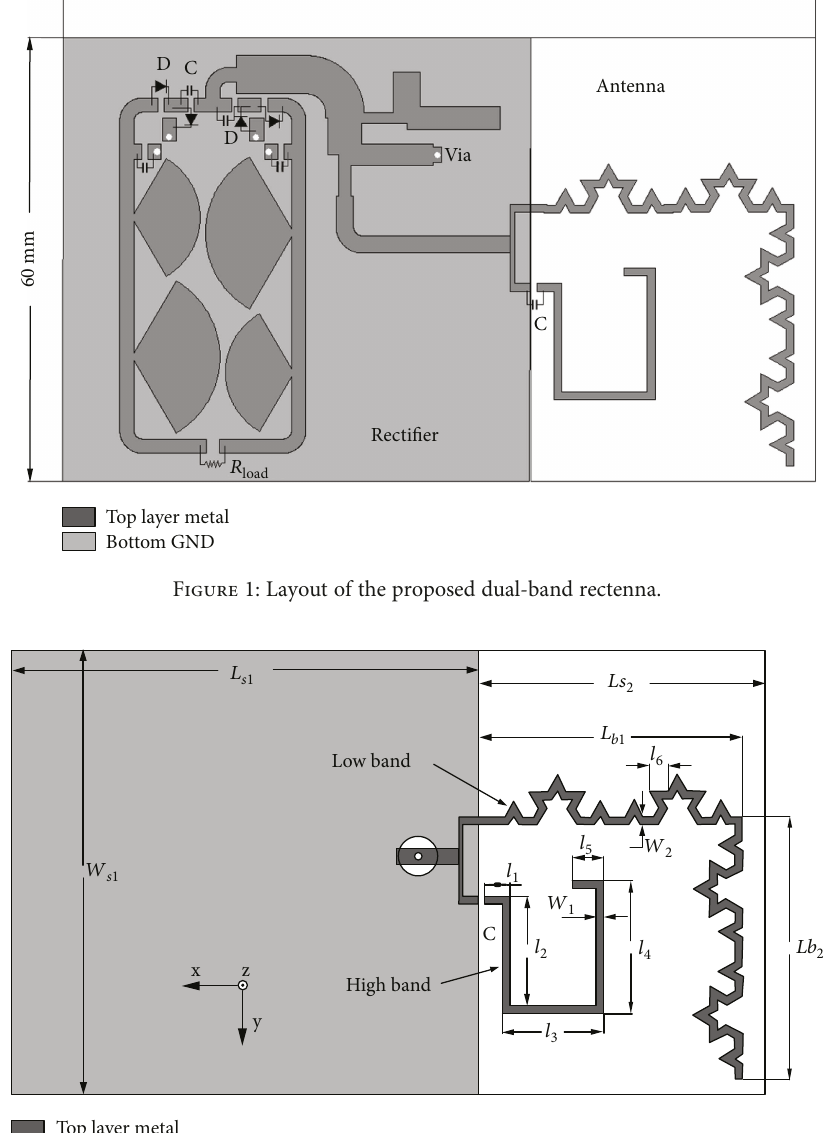
Figure 2: Layout of the proposed antenna ( w L =59.83, L s 1